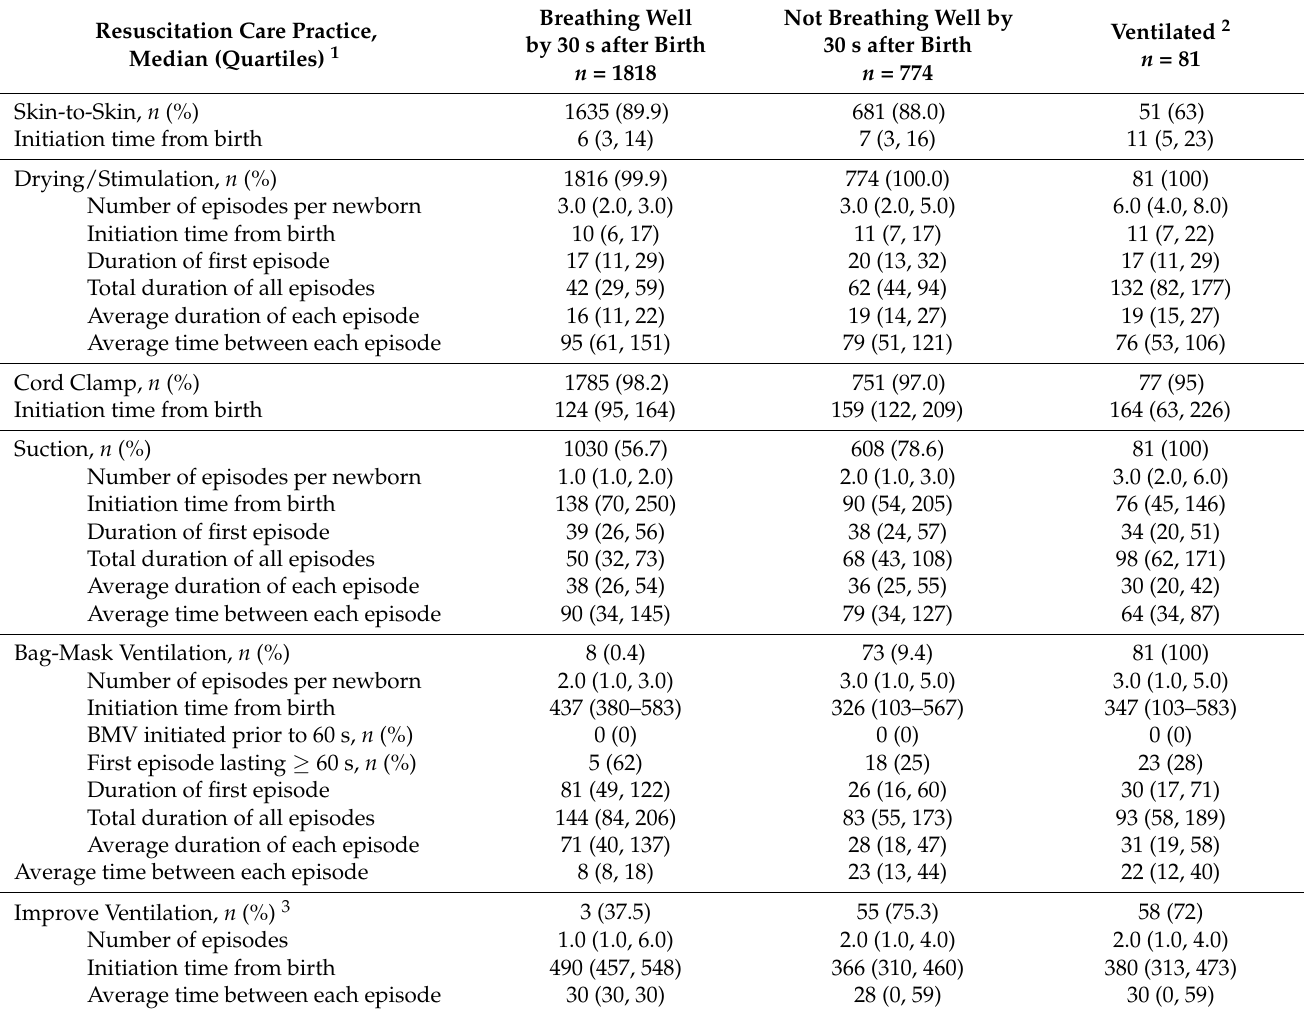
Table 3. Timing and duration of resuscitation care practices for liveborn